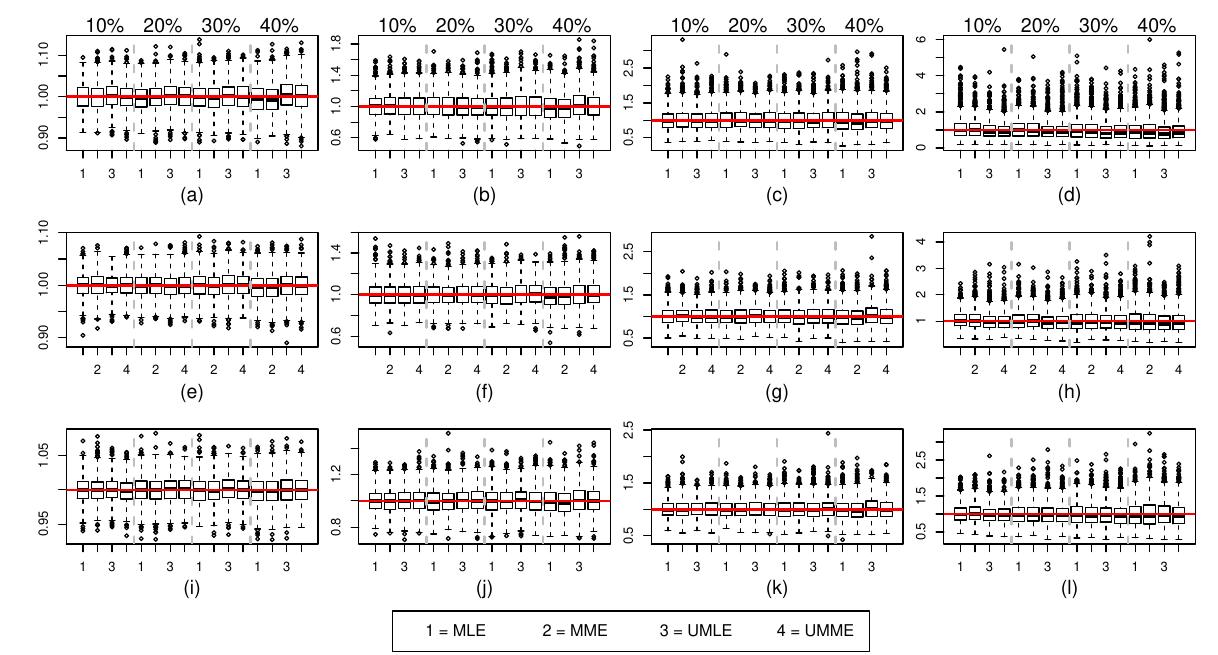
Figure 2. Sampled β values for n = 10 (top panel), n = 20 (middle panel), and n = 30 (bottom panel) for various censoring percentages and α values. The true value of β (= 1 ) is denoted by red colored solid line. α = 0.1 in ( a , e , i ), α = 0.5 in ( b , f , j ), α = 1.0 in ( c , g , k ), and α = 2.0 in ( d , h , l ).